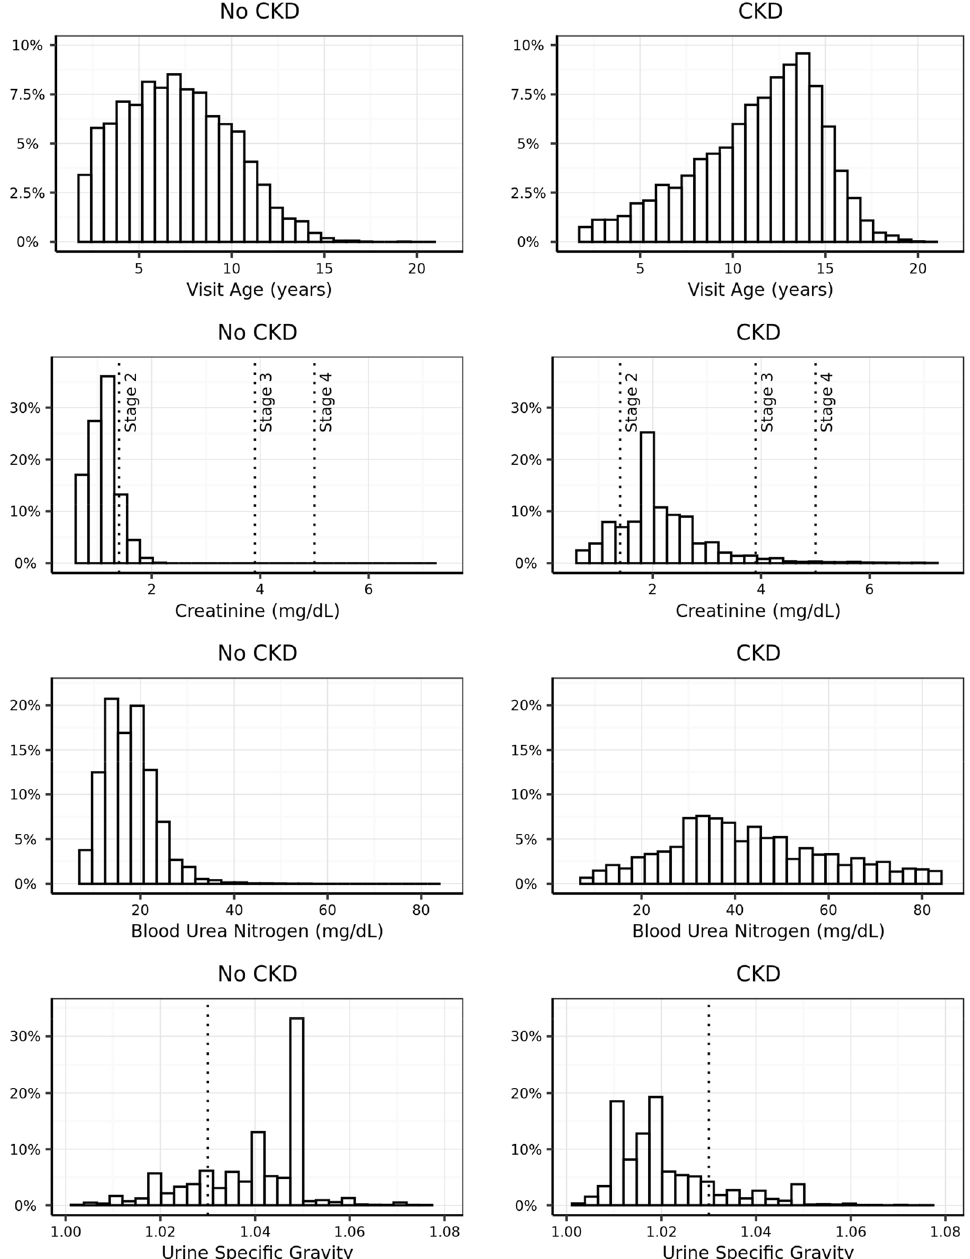
Figure 3. Distribution of age, creatinine, BUN and USG at the time of evaluation (T0) in the study EHR set differentiated by CKD status. Dotted lines on the creatinine line and USG plots show limits used for staging